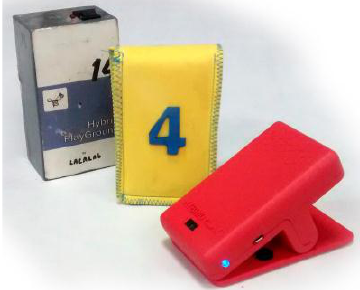
Figure 2. The HybridPLAY sensor. From left to right, the first, second and third versions.